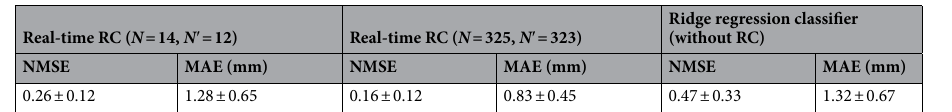
Table 1. Comparison of predictions by real-time RC and ridge regression classifier algorithm. In real-time RC method, N = 14 , N ′ = 12 are chosen for the reservoir layer. (Testing conditions: h p = 10, t p = 333 ms).